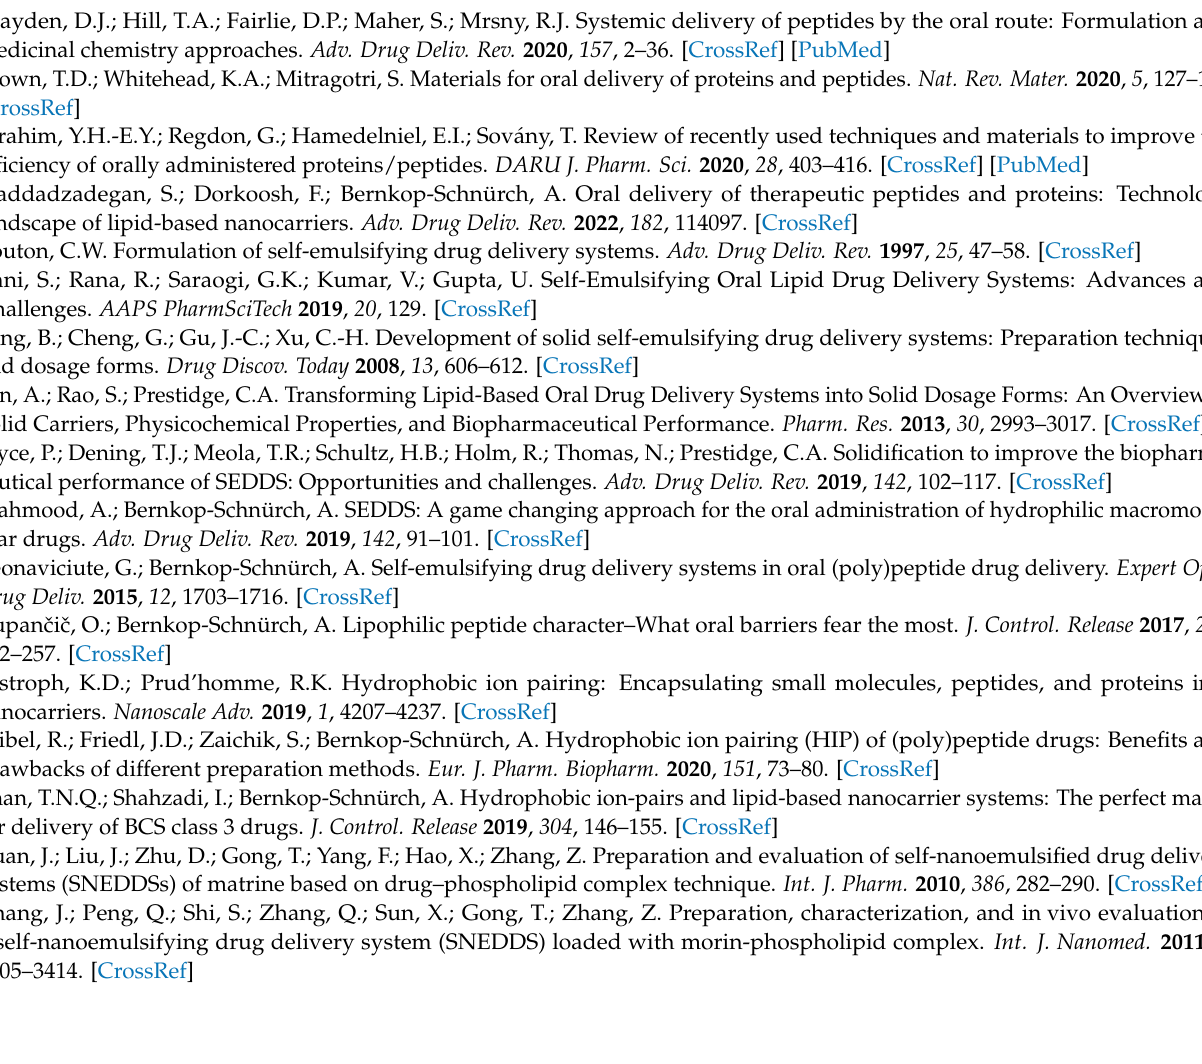
tistical results; Table S5: Mixture design-detail statistical results; Table S6: Properties of investigated solid carriers and their ability to adsorb optimal liquid SEDDS